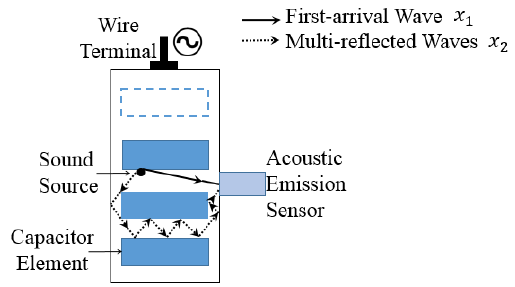
Figure 4. Propagation paths of ultrasound waves in an MFC.